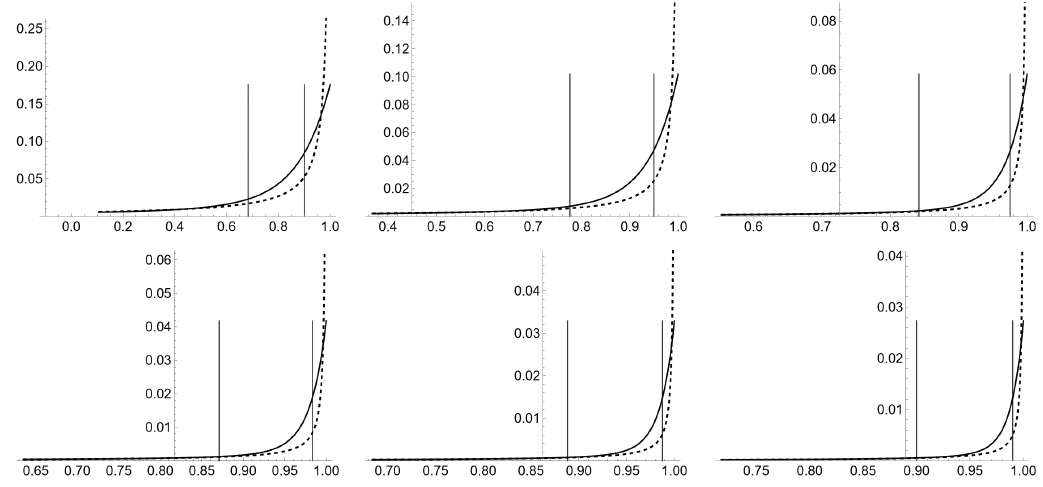
Figure 2 . Graphs of the exact formula (3.30) — the black line, and the approximation (3.33) — the dashed thick line, for N = 20 , 40 , 80 , 120 , 160 , 200 (left to right, top to bottom). The parameter on the horizontal axis is u = cos ϑ and the two vertical lines are at u = 1 − We can see that the approximation is reliable only up to roughly the first of these values. Note that the u axis is shifted and rescaled such that the relevant region is visible.